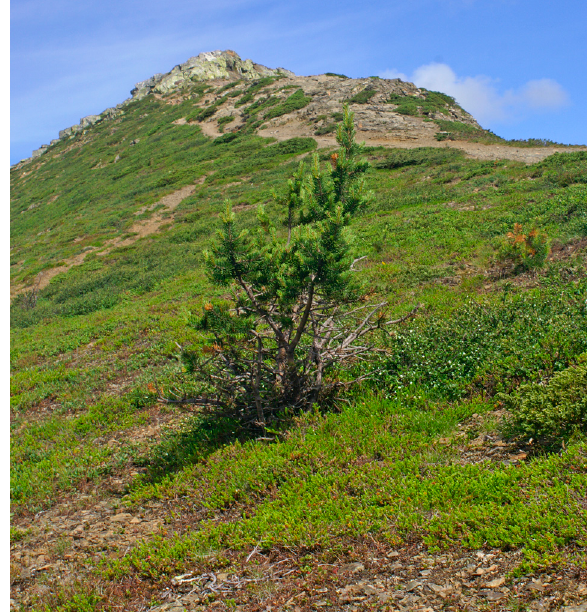
Figure 31: Young and near tree-sized pine growing about 30 m above the local treeline. Mt. Städjan, 975 m a.s. l., 14 July 2007.